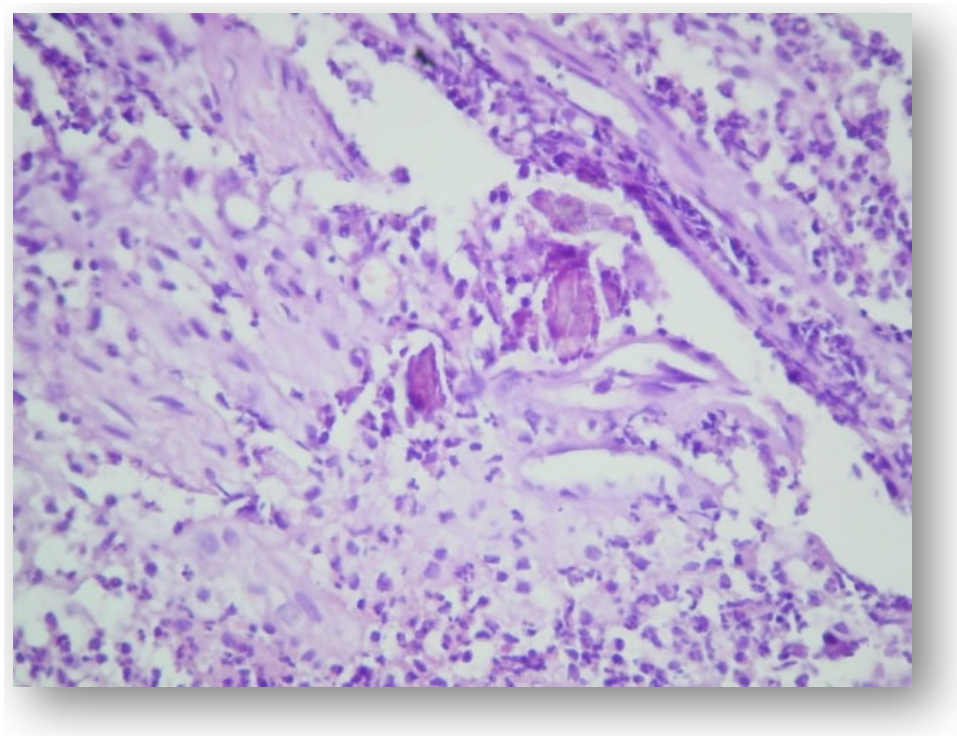
Figure 9. Radicular dental pulp tissue of a 70 year old female, type 2 diabetes HE staining, ×200.